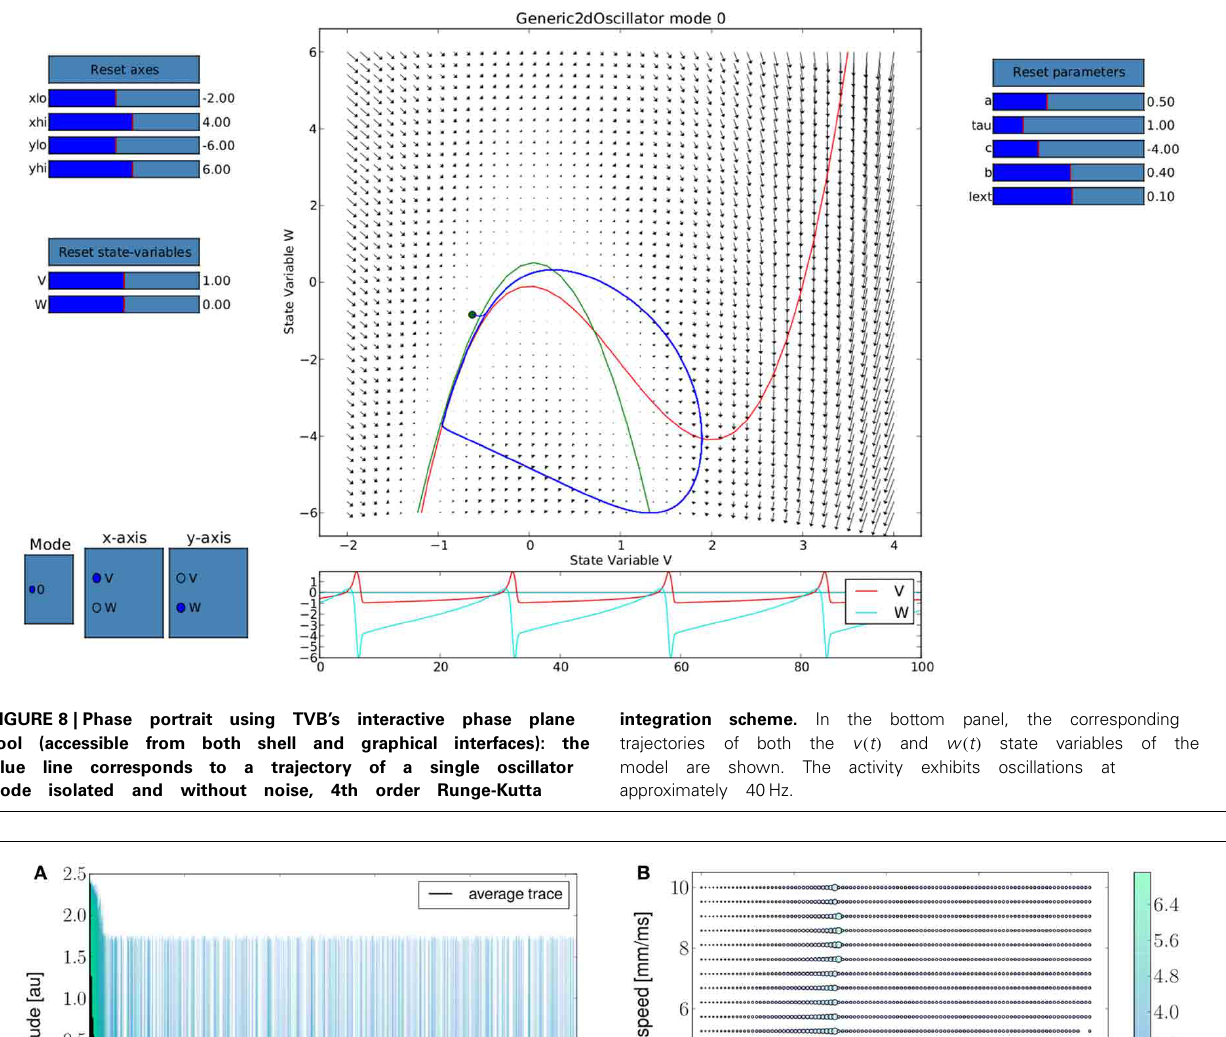
parameter space exploration to rapidly gain insights of the whole brain dynamics repertoire. In this plot, the magnitude and color scale correspond to one the variance computed over all the elements of the N-dimensional output array ( Global Variance ). Simulations were performed on a cluster based on the Python demo scripts available in the release packages. On of the major strengths of The Virtual Brain is that G-Users are enabled to launch parameter sweeps through the UI without the need to know how to submit parallel jobs (see Figure 10